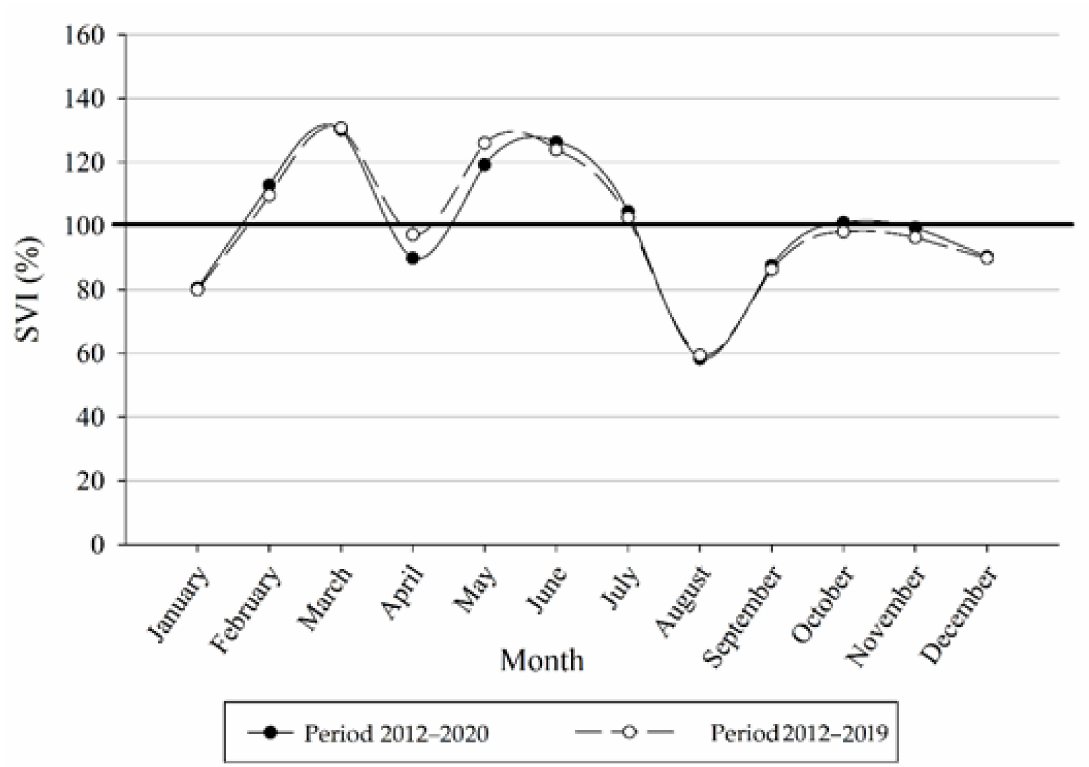
Figure 20. Seasonality pattern of vehicle embarking traffic of the port of Valencia during the periods 2012–2019 and 2012–2020.